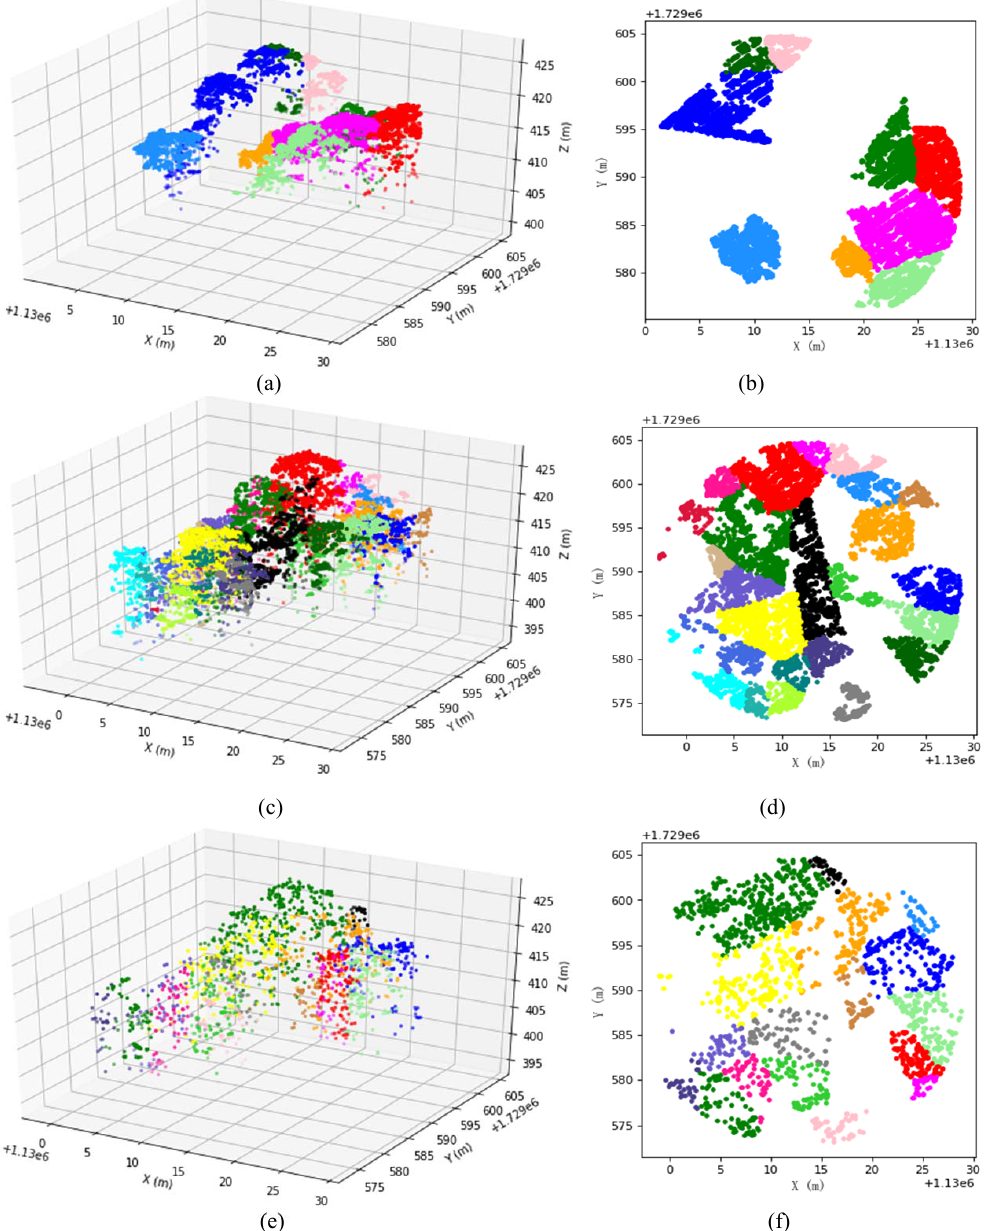
Figure 7. An example of multiple resolution threshold segmentation for isolated canopy layers. ( a , c , e ) are 3D views of tree segments of the first, second and third layer, respectively; ( b , d , f ) are their top views. The color of points indicates individual tree